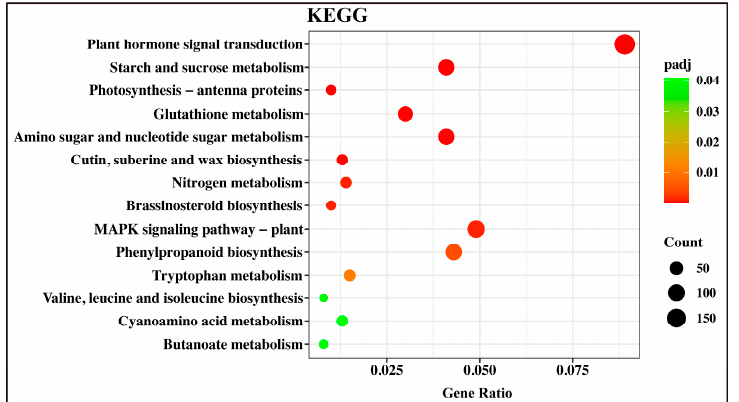
Figure 7. Scatter plot of KEGG pathway enrichment statistics. Rich factor is the ratio of differentially expressed gene numbers annotated in this pathway term. Greater rich factor means more demanding.